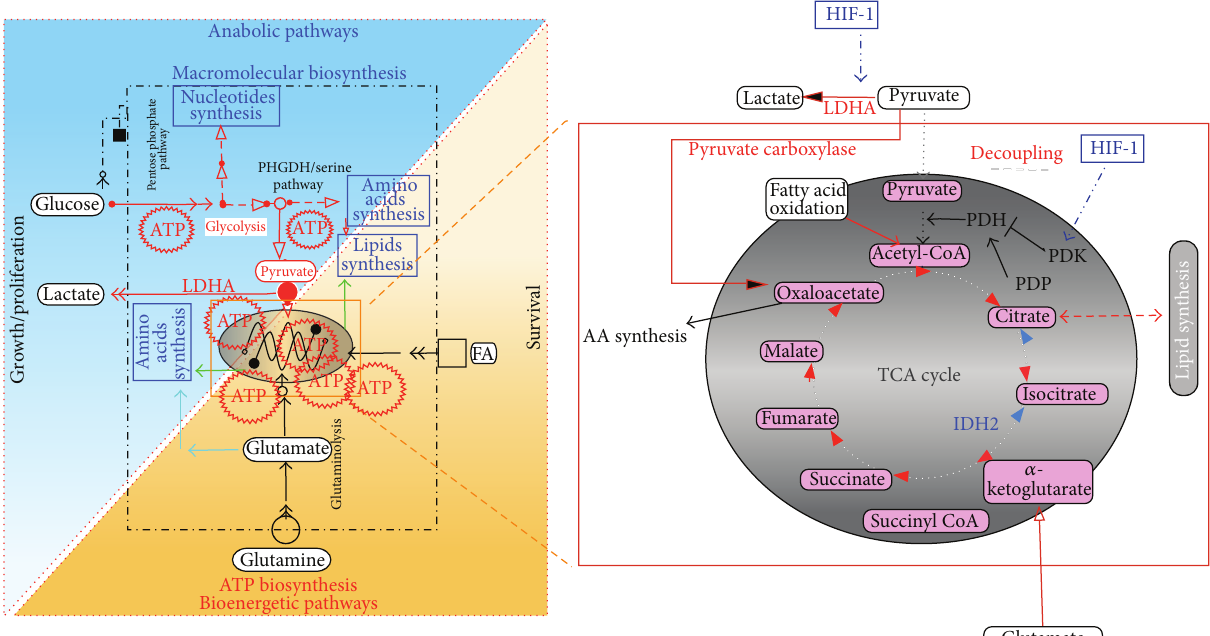
Figure2:Schematicdiagramofmetabolicnetworksplacingmitochondriaatthecenterofanabolicandbioenergeticspathwaysincancercells. Anabolic pathways are responsible for the production of macromolecules used for growth and proliferation of cancer cells. Red lines indicate glycolysis: multisteps conversion of glucose to pyruvate and pyruvate to lactate allowing the flux of glucose intermediates to fulfill anabolic pathways such as the pentose phosphate pathway and the PHGDH/serine pathway for nucleotides, lipids, and AA biosynthesis (see text for details). The decoupling of glycolysis from mitochondria is also observed. Mitochondria participate in ATP production through oxidation of alternative substrates such as glutamine or fatty acid (FA). Furthermore, mitochondria are also involved in anabolic pathways for producing building blocks (AA, lipids). Glutamine refills TCA intermediates (anaplerosis) and can feed the reverse TCA cycle for lipid synthesis (blue arrows) (see text for